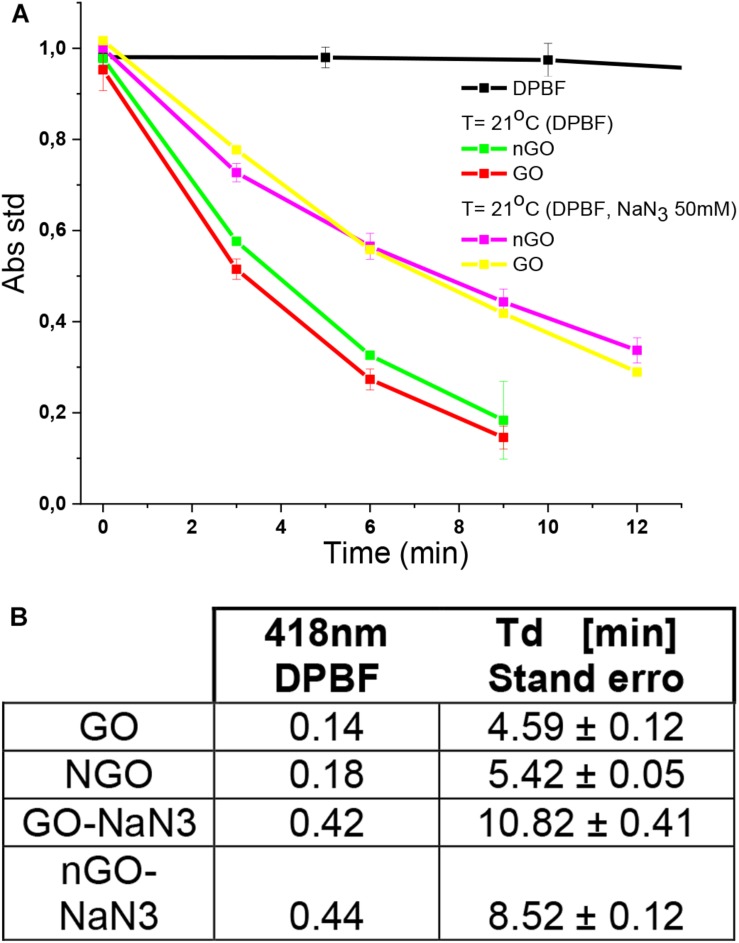
(A) Decay curve of DPBF at 21°C. (B) Time decay of DPBF from GO and nGO. DPBF = 5 μm, GO = 30 μg ml–1, nGO = 31.7μg ml–1, and NaN3 = 50 mM.